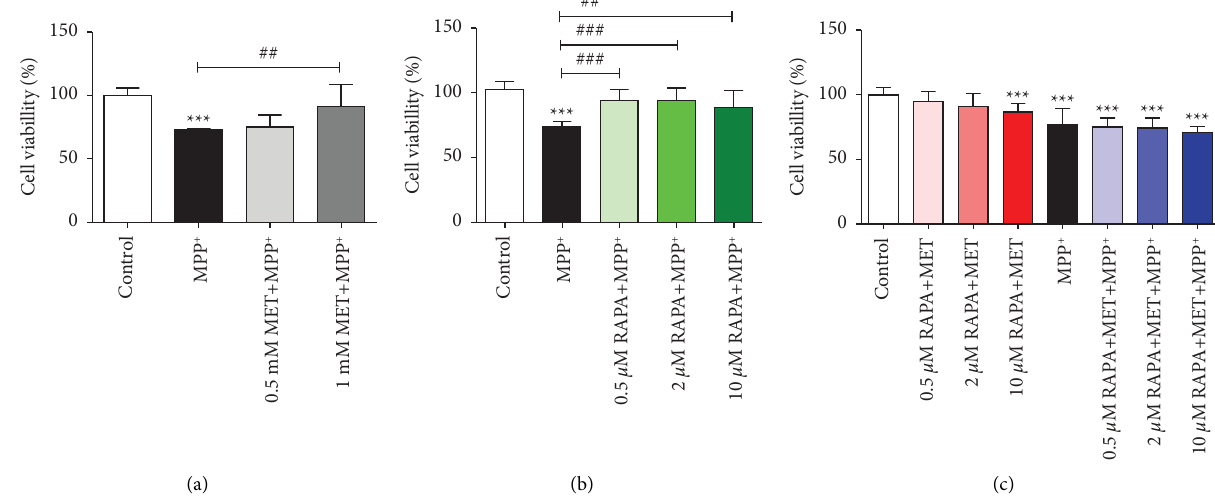
Figure 3: Efects of pretreatment of MET, RAPA, and MET and RAPA combinations on cell viability of MPP + -treated diferentiated SH- SY5Y cells. Cell viability was assessed using an MTTassay. After pretreatment of (a) MET, (b) RAPA, and (c) METand RAPA combinations for 24hours, cells were exposed to 700 μ M MPP + for 24hours. Values represent mean ± SEM ( n � 3 with triplicates each). ∗∗∗ p < 0 . 001 compared with the control group. ## p < 0 . 01, ### p < 0 . 001 compared with the MPP + group.